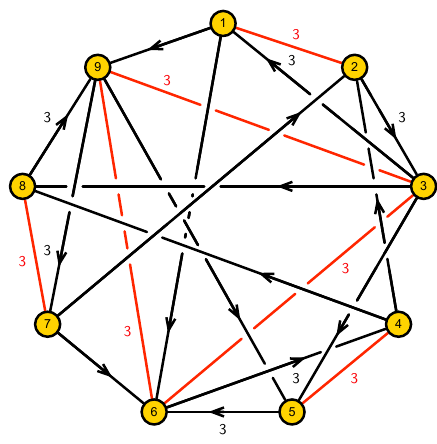
Figure 20 . Quiver for Y 3 , 4 ( CP 2 )